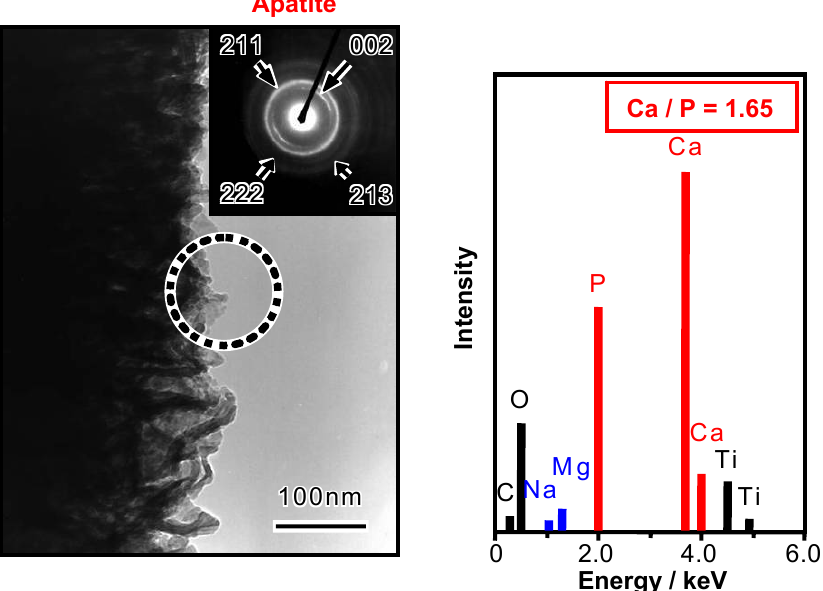
Figure 6. TEM photograph and EDX spectrum of the surface of the NaOH- and heat- treated Ti metal after soaking in SBF for 5 d (dotted circle: area of electron diffraction and EDX